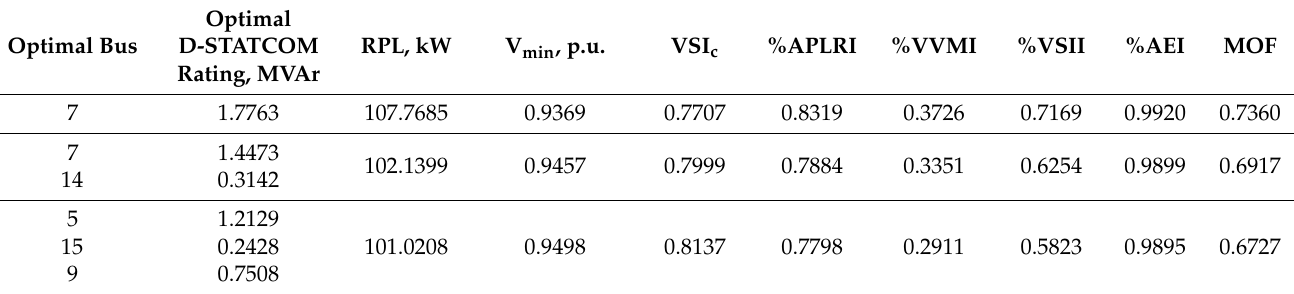
Table 5. Comparison of results for OADS using SPBO algorithm for 51-bus